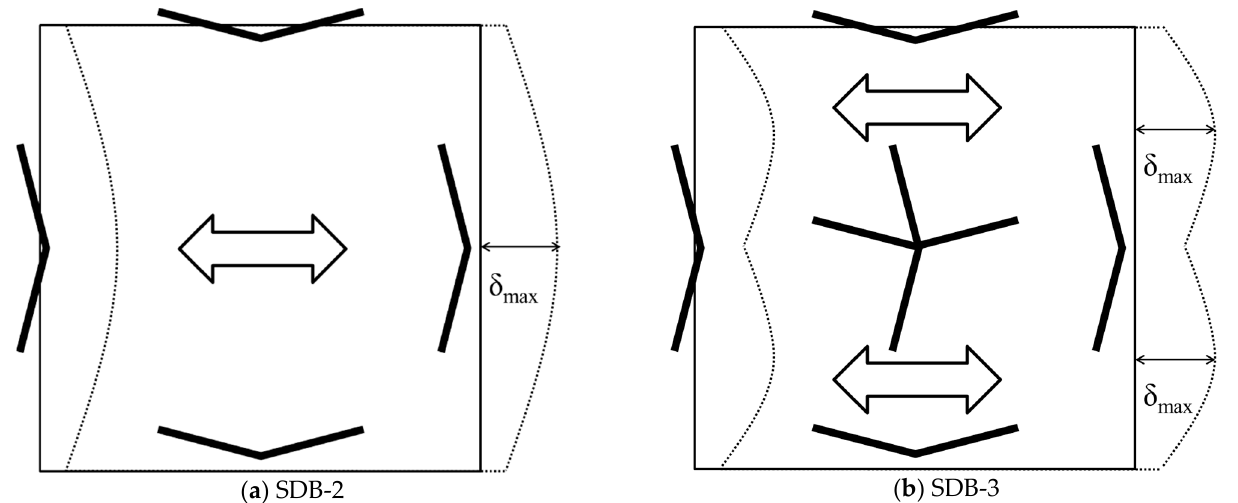
Figure 14. Relative displacement between the test frame and the ceiling systems: ( a ) SDB-2, Test 8 (2.16 g); ( b ) SDB-3, Test 8 (2.16 g).